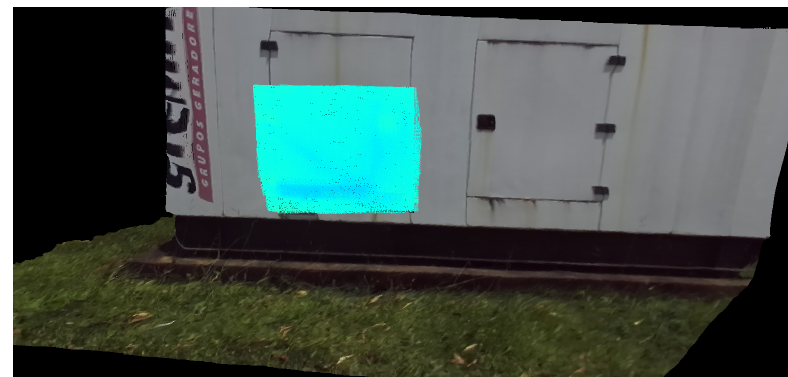
Figure 15. Temperature correction in the 3D model due to a reading from another